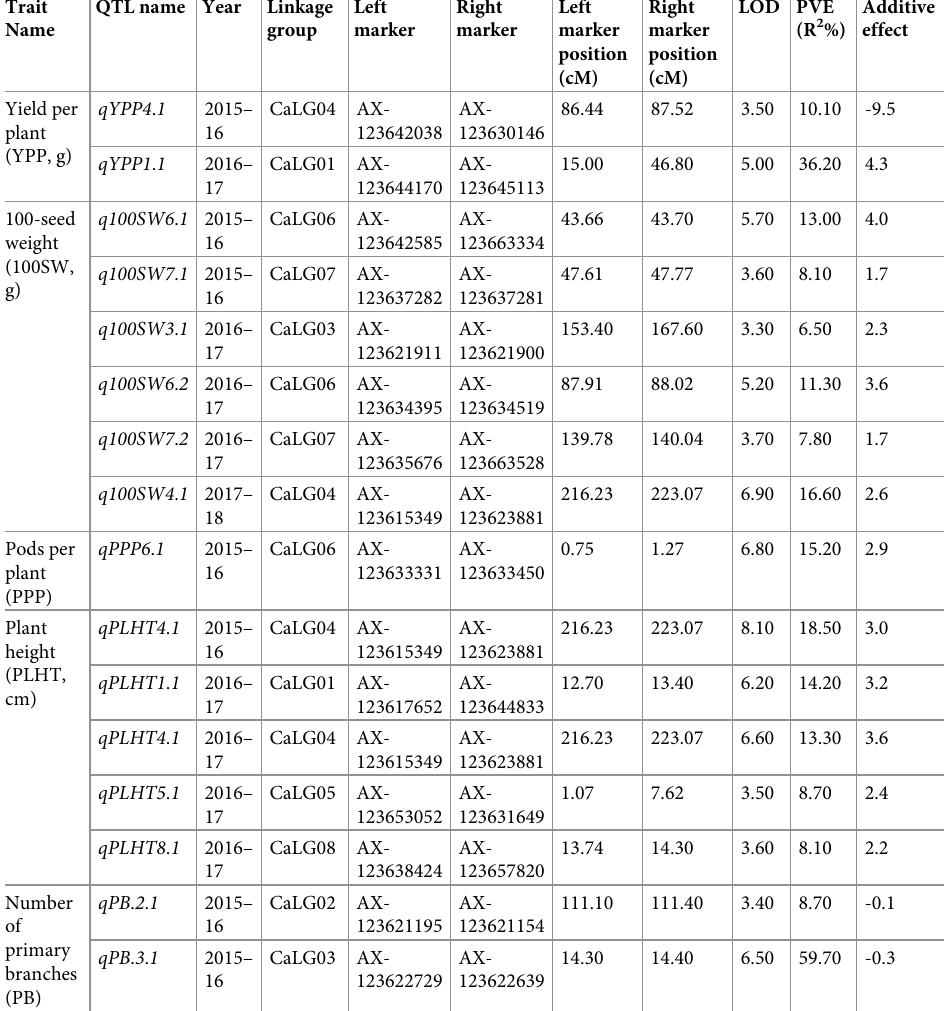
Table 3. List of QTLs identified for yield, yield components and agronomic traits in ICC 4958 × DCP 92–3 RIL